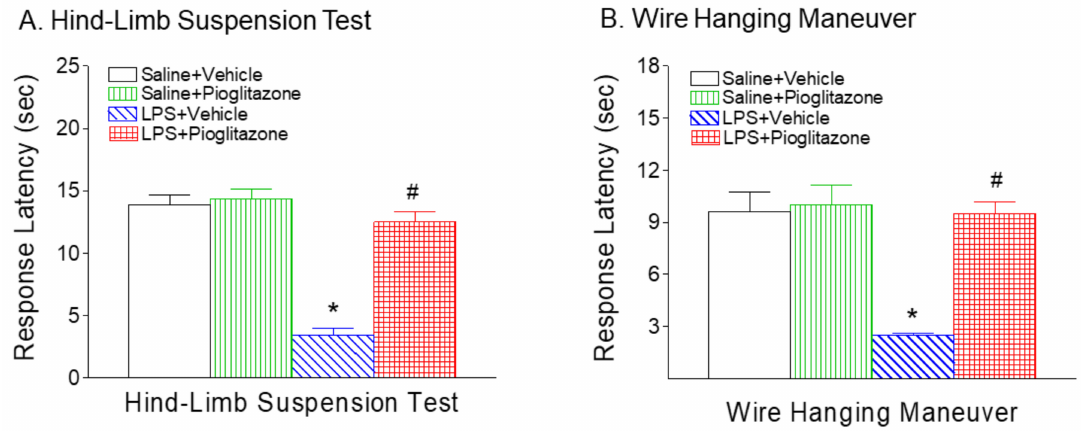
Figure 2. Pioglitazone attenuated neonatal LPS-induced reduction of mean latency times in hanging onto the edge of the tube in the hind-limb suspension test ( A ), and wire hanging maneuver ( B ) in the rat. The results are expressed as the mean ± SEM of eight animals in each group, and analyzed by two-way ANOVA, followed by the Student–Newman–Keuls test. * p < 0.05 represents a significant difference for the LPS + Vehicle group as compared with the Saline + Vehicle group. # p < 0.05 represents a significant difference for the LPS + Pioglitazone group as compared with the LPS + Vehicle group.